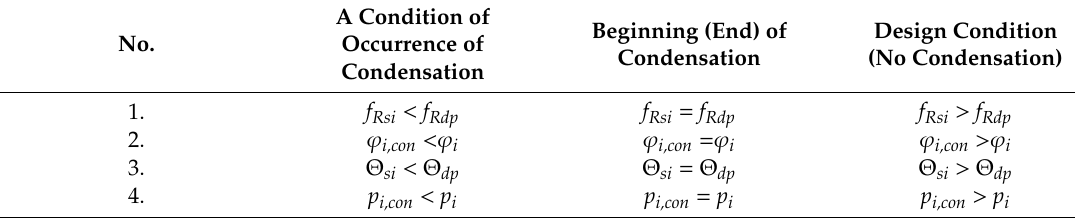
Table 3. Conditions for the occurrence of surface condensation on a building